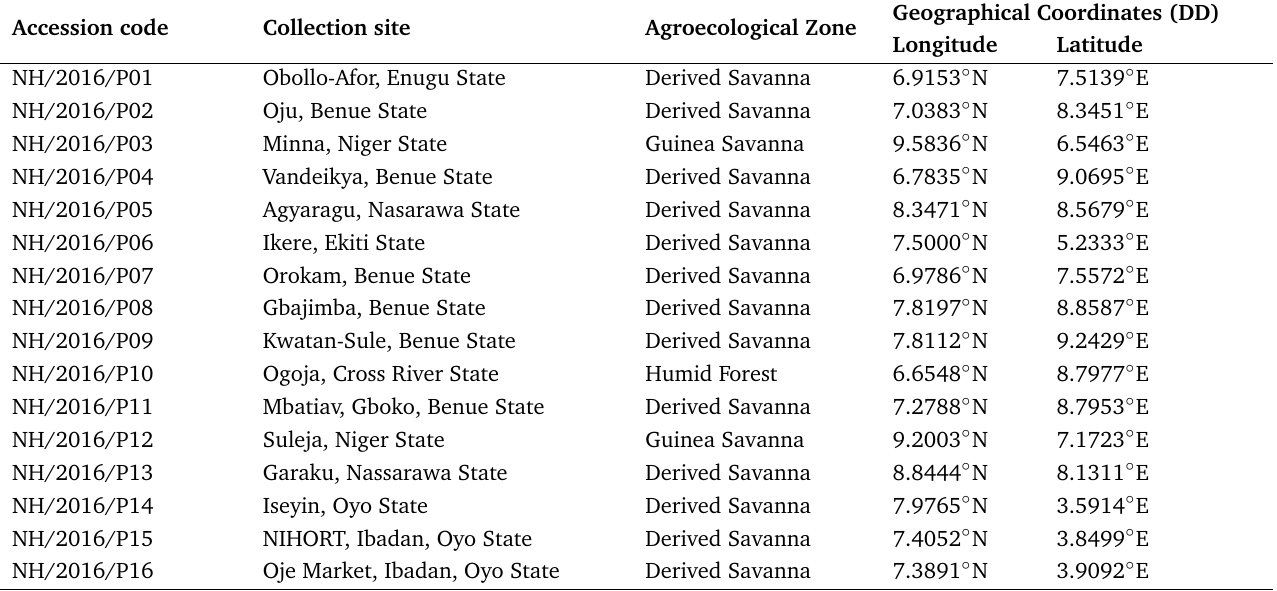
Table 1. Parkia biglobosa accessions used in this study and collection